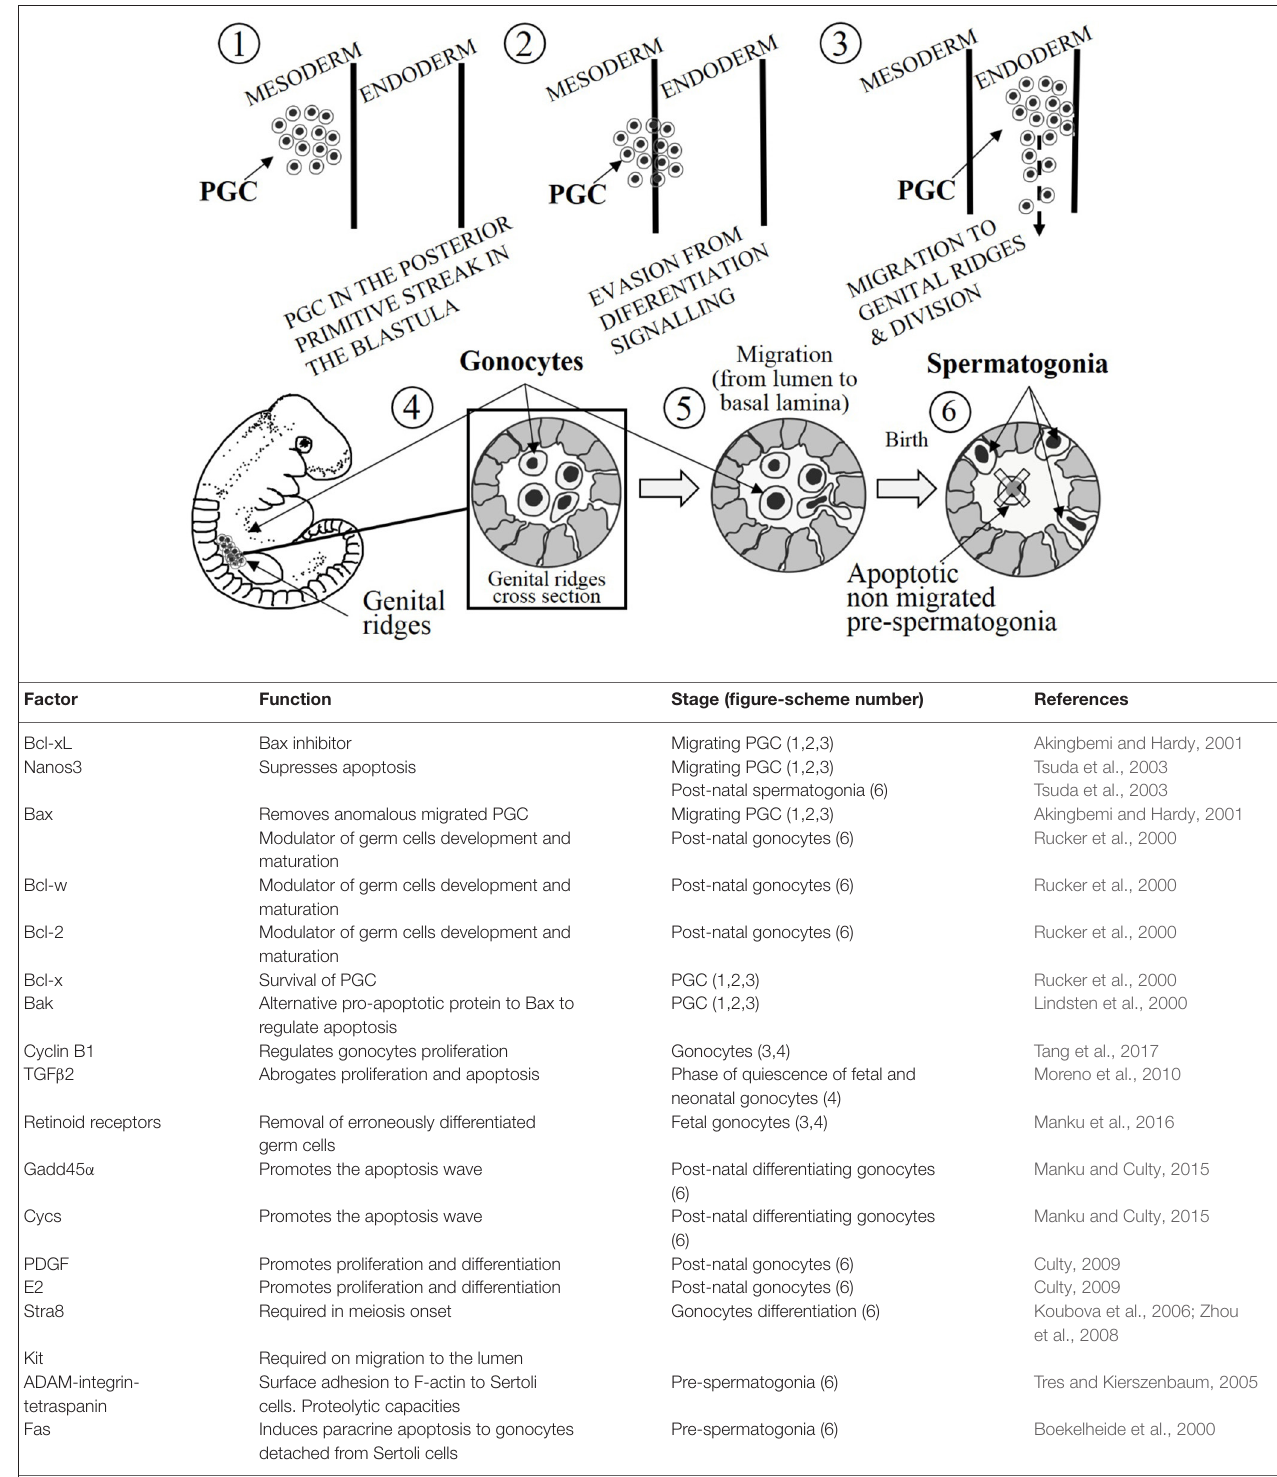
FIGURE 1 | (Upper) A schematic illustration of development of germ cells. The numbers inside the circles are tagging the mentioned stages during the development. (Lower) The table summarizes the main apoptosis-related factors, their functions and the stages represented in the upper illustration (number in brackets).